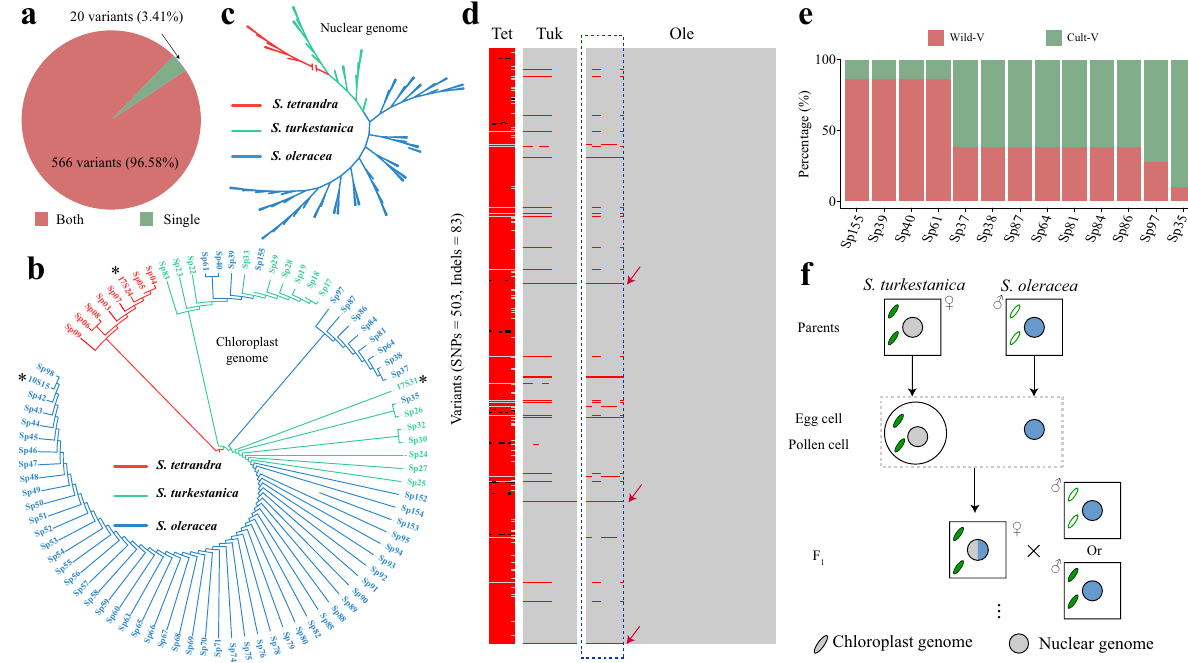
Figure 4. Population genetic analysis of the 85 Spinacia species. ( a ) Comparison of the variant data detected by the 82 resequencing accessions and the three complete chloroplast genomes. ‘Both’ indicates that the SNPs detected by 82 resequencing accessions were present in the SNP dataset from the three chloroplast genomes, whereas ‘Single’ indicates that the SNPs were specifically detected in the 82 resequencing accessions. A neighbor-joining tree of 85 Spinacia accession using the spinach variants’ ( b ) chloroplast genome and ( c ) nuclear genome. The individuals with asterisks are used to assembled in the study. ( d ) Variants in S. oleracea , S. turkestancia , and S. tetrandra . Gray lines indicate reference ( S. oleracea ) homozygous genotype, while red and black lines represent alternative homozygous and heterozygous genotype, respectively. The samples surrounded with blue dotted lines are the 13 S. oleracea clustered with S. turkestanica in ( b ). The red arrows mean the three conserved variants between S. oleracea and wild progenitors in Fig. 2c. Tet, S. tetrandra ; Tuk, S. turkestanica ; Ole, S. oleracea . ( e ) The percentage of variants (from wild or cultivar) in 29 variants existing in 13 S. oleracea clustered with S. turkestanica in Fig. D. Wild-V indicates the variants from wild species, while Cult-V represents the variants from cultivar species. ( f ) The inheritance patterns of the 13 S. oleracea